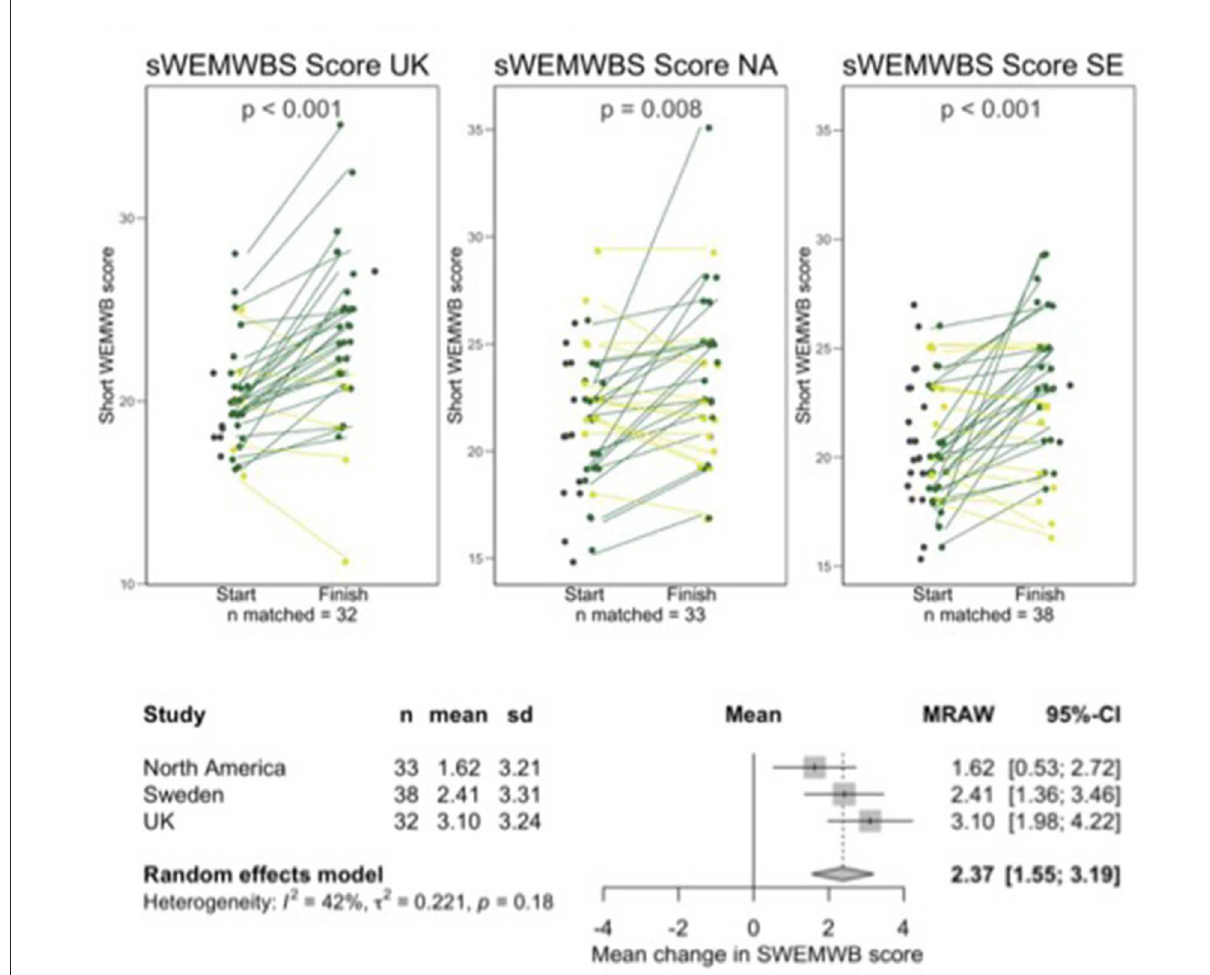
FIGURE3 Line and forest plots for SWEMWBS. Dark green indicates improved scores, light green indicates worsening score or no change. Dark gray data points without a line represent people who started but did not finish or who completed a follow up questionnaire but could not be matched with a starting